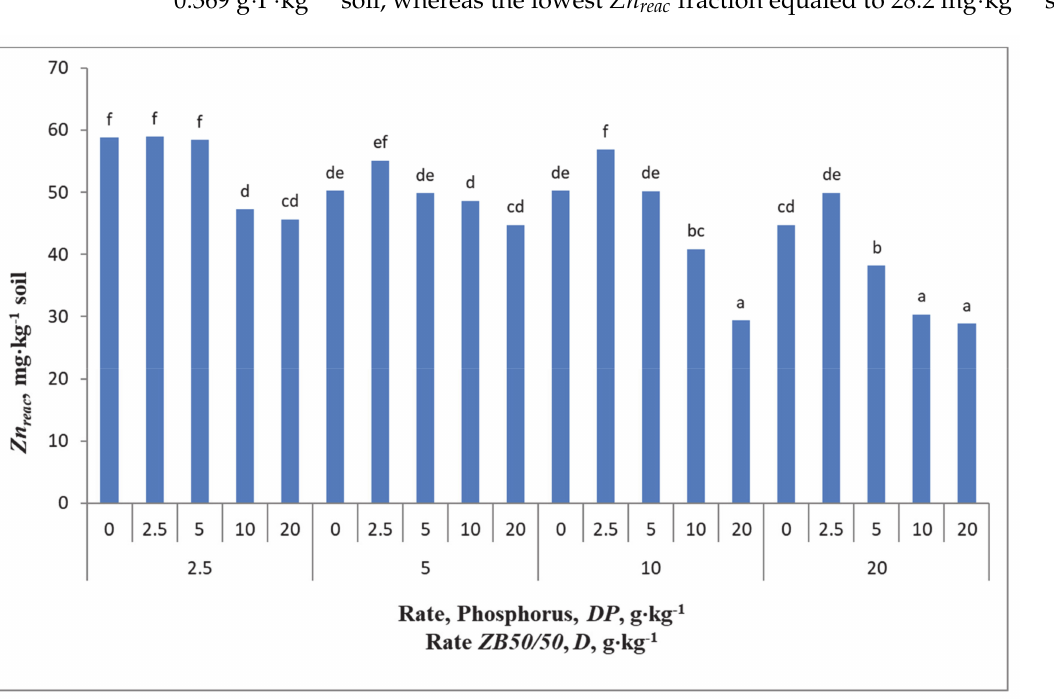
Figure 5. Content of the reactive zinc fraction ( Zn reac ) on the background of interactions ZB50/50 ( D ) and phosphorus ( DP ) rates. Small letters a to l refer to statistical differences among the tested treatments, the same letter means no significant differentiation. Table 9. Regression models elaborated for reactive Zn ( Zn reac ) fractions in treatments with